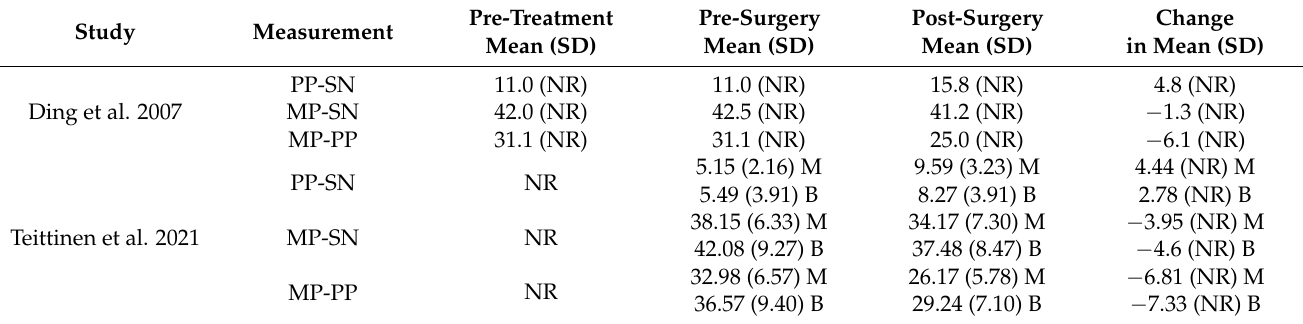
Table 13. Mean change in measurements indicating mandibular autorotation as a result of orthognathic surgery (degrees).